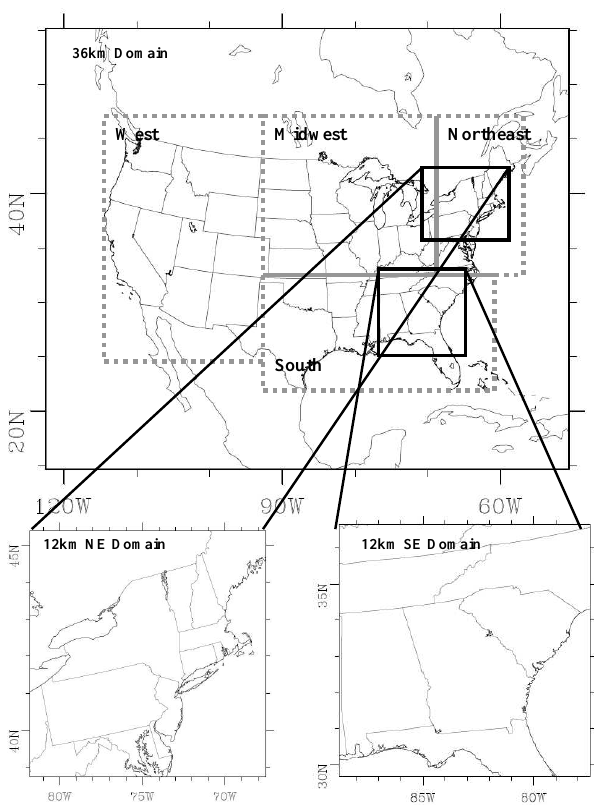
Figure 1: Modeling domains with horizontal grid-spacing resolutions of 36-km and 12-km 601 Fig. 1. Modeling domains with horizontal grid spacing resolutions Northeast (NE) and Southeast (SE). The dashed boxes indicate the four regions where model 602 of 36km and 12km Northeast (NE) and Southeast (SE). The dashed evaluation was conducted.603 boxes indicate the four regions where model evaluation was con-